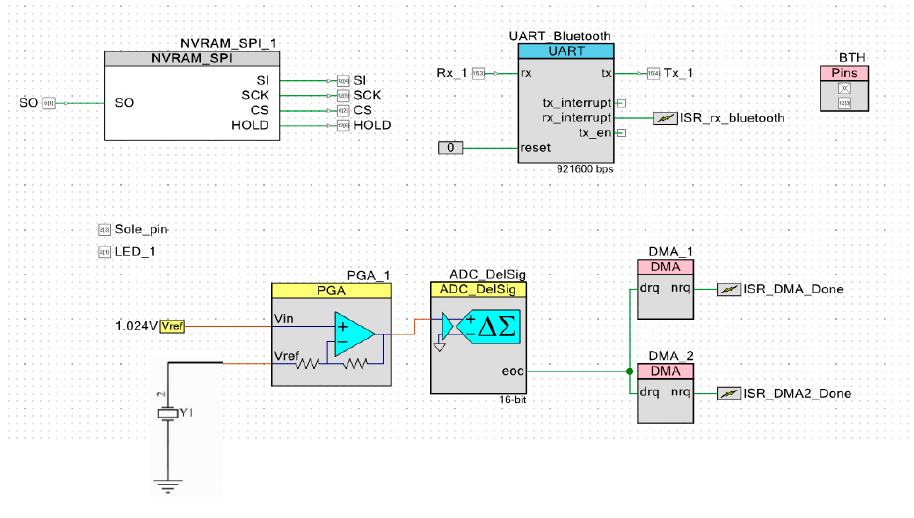
Figure 5. The PSoC 5LP block diagram.